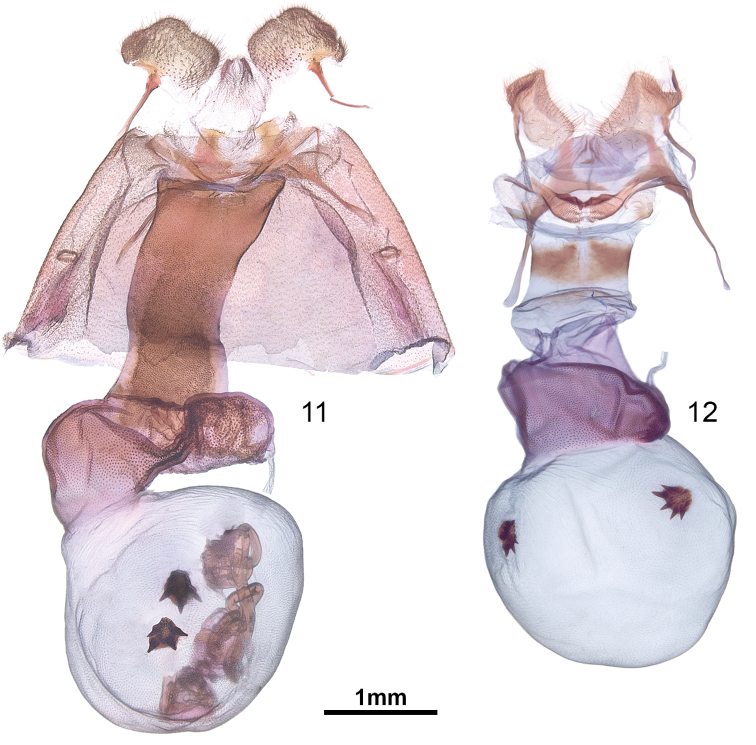
Female genitalia of 11Euchaetesnancyae and 12E.helena.